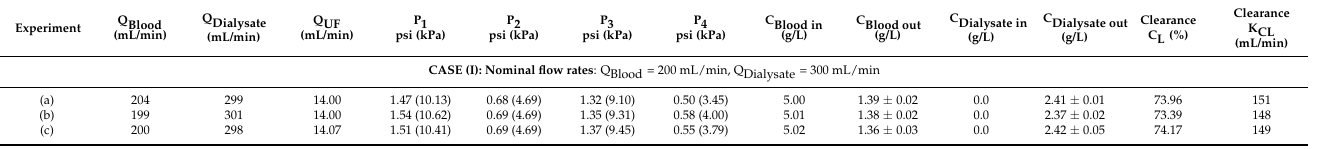
Table A1. Experimental data from the counter-current flow operating mode of haemofilter, for Cases I, II, III. Data listed include feed flow rates, external pressures, net ultrafiltration rate Q UF , urea concentration at the inlet and outlet of blood- and dialysate- side, urea